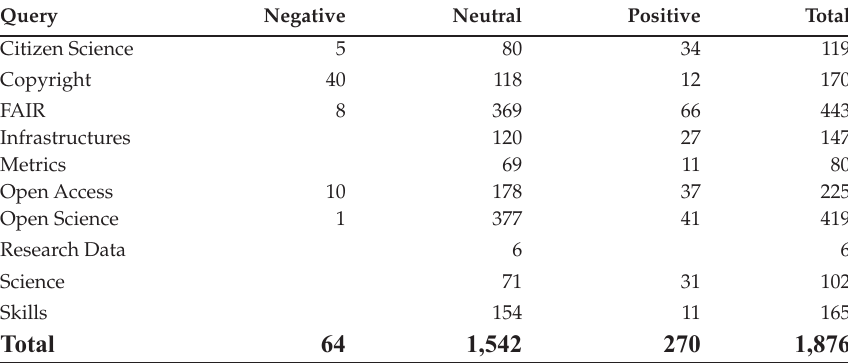
Table 1. Queries